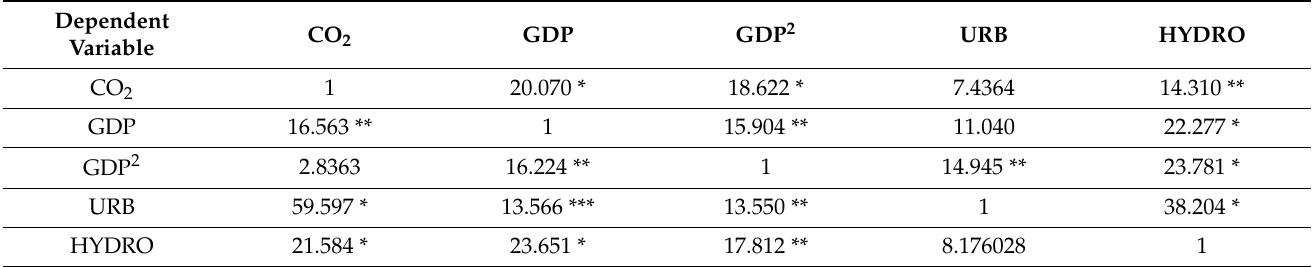
Table 4. Gradual shift causality outcomes.